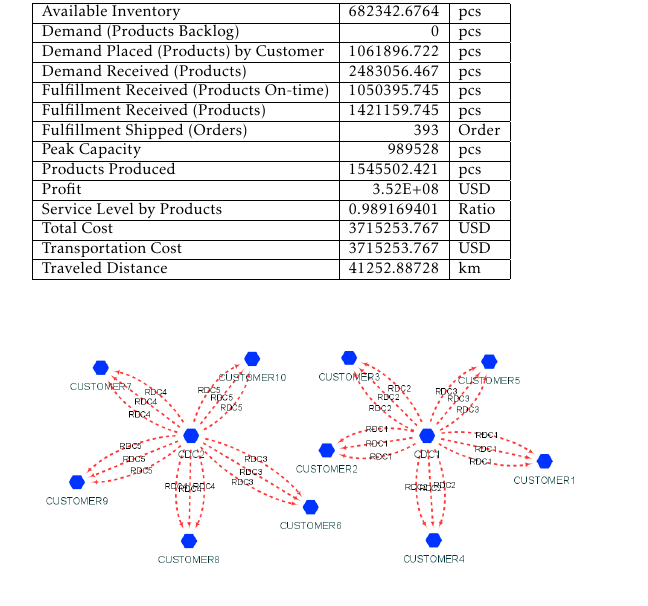
Table 5. Key performance indicators of proposal solution Available Inventory